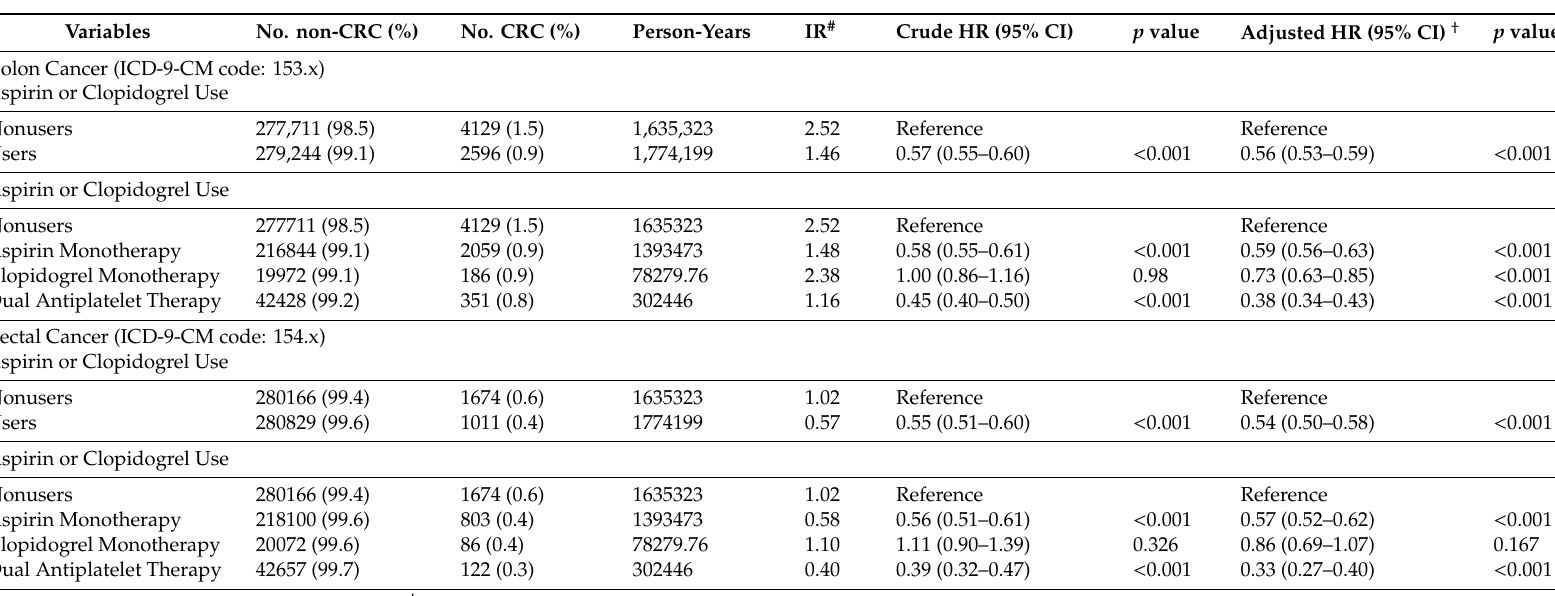
Table 4. Incidence rate and hazard ratio of colon cancer and rectal cancer in patients with T2DM using aspirin and clopidogrel or not.